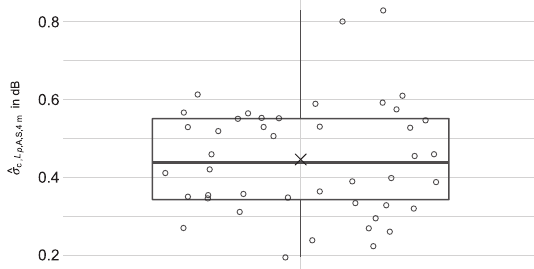
Figure 4. Boxplot of ^ r c ; L for all 44 measurement paths. p ; A ; S ; 4m The results for the individual calculations are indicated as circles, the mean value is represented by x .